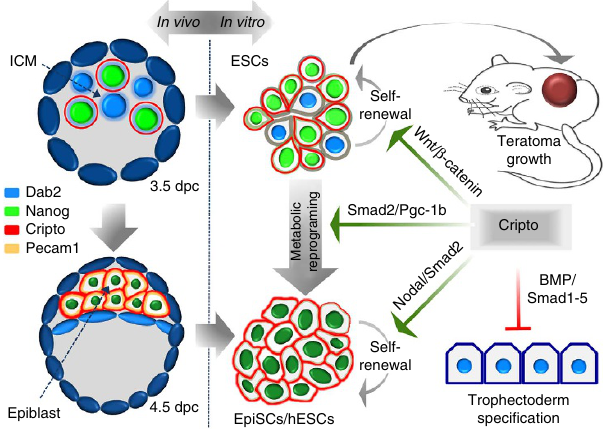
Figure 9 | Schematic summary of Cripto activity in naive and primed pluripotent stem cell states. Cripto is one of the earliest EPI markers. Cripto-positive cells display a salt-and-pepper distribution and co-localize with Nanog-positive cells (light green) within the ICM of the pre-implantation blastocyst (E3.5). Next, Cripto expression becomes homogeneous in the late blastocyst (E4.5), marking all the cells of the EPI (dark green), whereas it is absent in both the TE (dark blue) and in the PrE (light blue). In mouse ESCs, surface Cripto is heterogeneous and highly dynamic and correlates with high levels of pluripotency markers. Moreover, Cripto regulates mouse ESC self-renewal by positively modulating the canonical Wnt/ b -catenin pathway. Conversely, Cripto regulates the metabolic reprogramming that occurs in the transition from ESCs to EpiSCs, at least in part through the Nodal/Smad2/Pgc-1b axis. Finally, Cripto/Nodal/Smad2 sustains mouse EpiSC/hESC self-renewal and prevents transdifferentiation towards the trophoblast lineage, by repressing BMP/Smad1-5 signalling. Our findings place Cripto at the interface of the mouse and human pluripotency networks, and provide unprecedented evidence that it restricts ESC differentiation potential towards embryonic